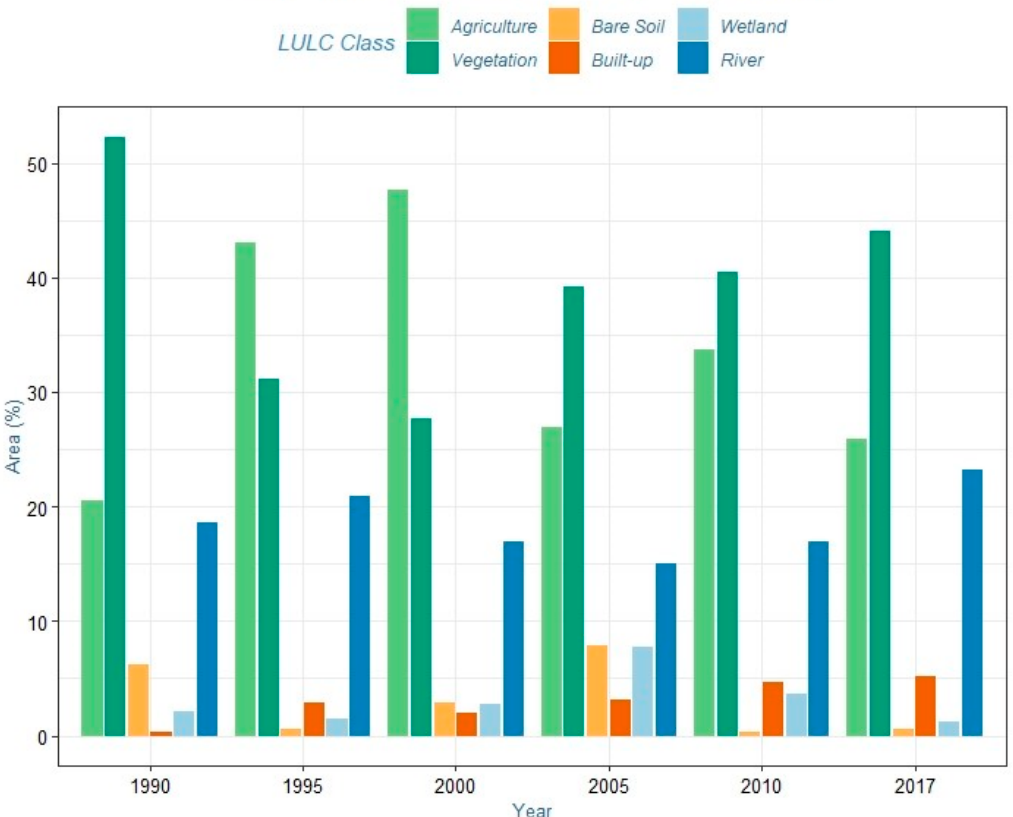
Figure 4. Percent area distribution of each land cover class between 1990 and 2017, obtained by the XGBoost-RF classifier.